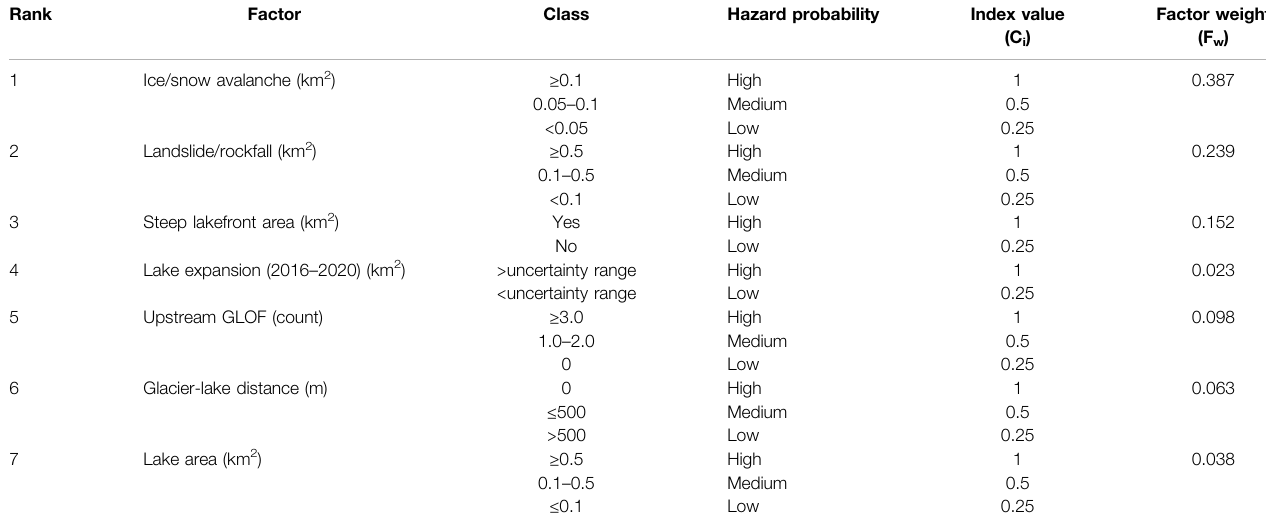
TABLE 2 | Selected factors with classes and associated index values. The weight of each factor is computed using the AHP.